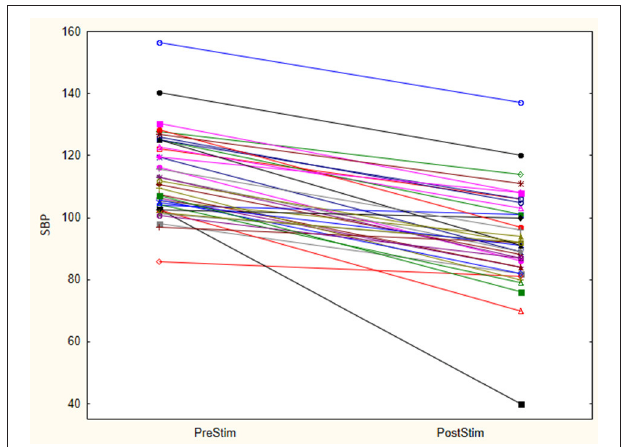
FIGURE 2 | The box plot for the results of systolic blood pressure lowering in 21). the pilot phase using the Octad probe. The results of the distribution of the = median are shown in the figure, together with the p -value after applying the Wilcoxin rank test. Systolic blood pressure values are represented in mmHg.